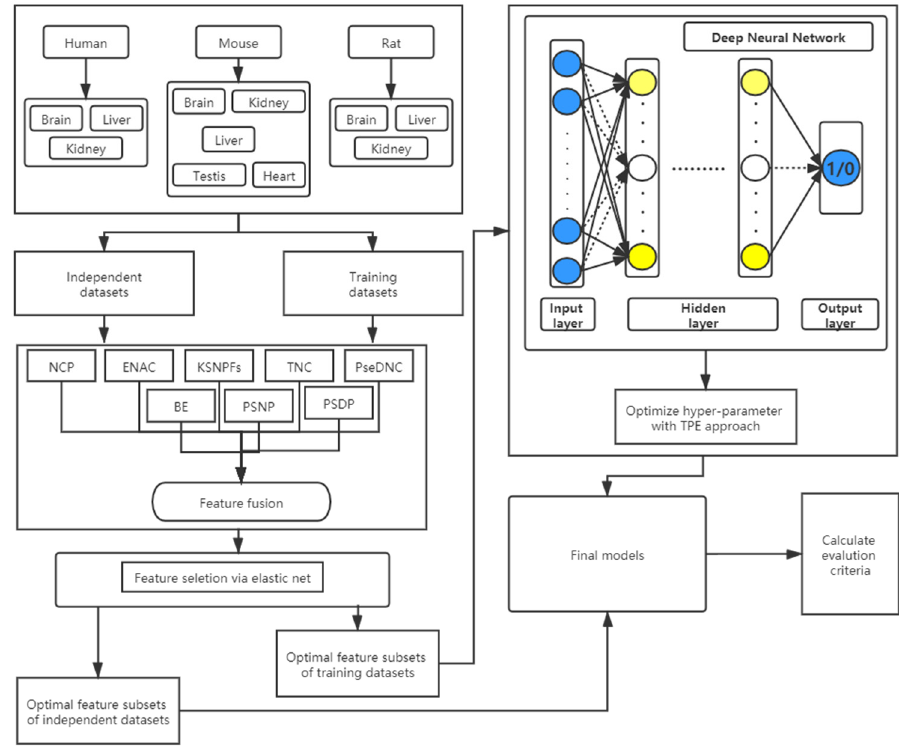
Figure 1. The flowchart of the DNN-m6A